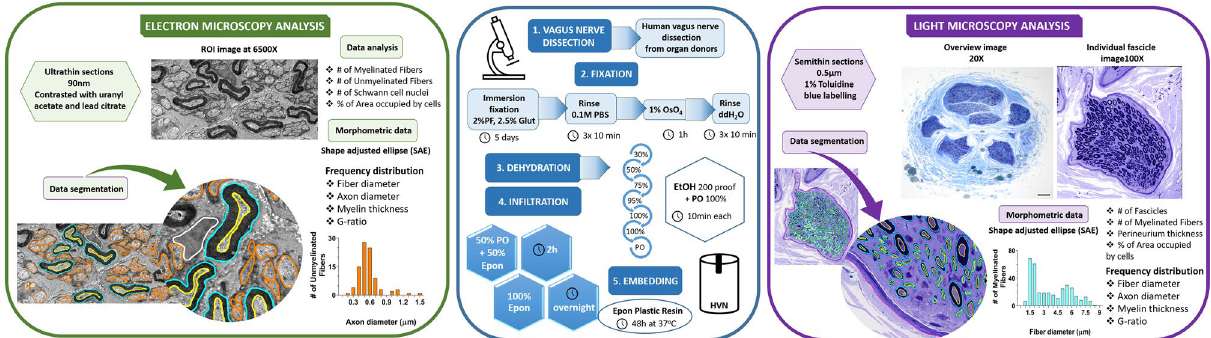
Figure 6. Summary of tissue processing steps and analysis of human organ donor-derived vagus nerve samples for LM and EM studies. Please note that the tissue fixation and embedding steps of human vagus nerve tissues are shared. The tissue sectioning of embedded tissue blocks, contrasting or staining, and imaging are performed according to LM- and EM-specific protocols. Data segmentation for morphological mapping studies